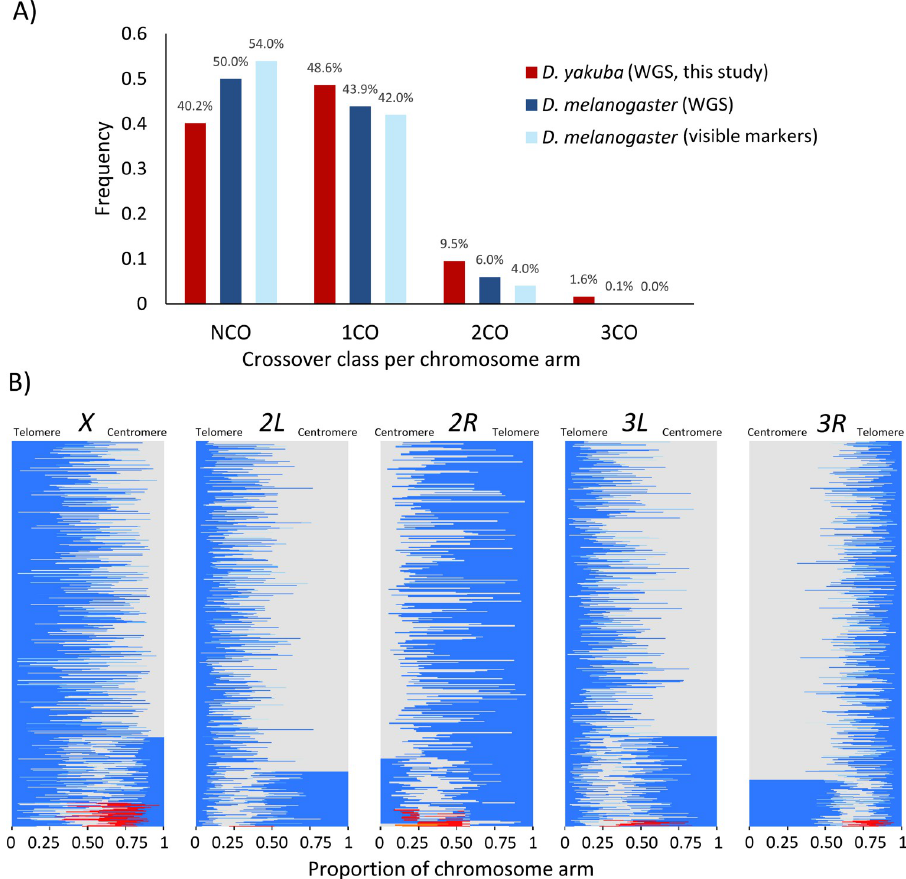
Fig 2. Number and distribution of crossovers. A) Observed crossovers per chromatid in D . yakuba (this study) and D . melanogaster (see Materials and Methods for details). Note that studies using visible markers are based on much larger sample sizes but, at the same time, may underestimate crossover events due to limited density of markers along chromosome arms. NCO: non-crossover, 1CO: single crossover, 2CO: double crossover, 3CO: triple crossover, 4CO: quadruple crossovers per chromosome arm. B) Relative location of crossovers along chromosome arms in D . yakuba . Each horizontal line represents a chromosome with one or more crossovers. A change in color represents a crossover event, starting from the telomere (blue). Chromosome arms have been ordered based on crossover class for better visualization, from 1CO (top) to 4 CO (bottom). Number of chromatids analyzed ( n ): X : n = 1,622; 2L : n = 1,661; 2R : n = 841; 3L : n = 1,701; 3R : n =